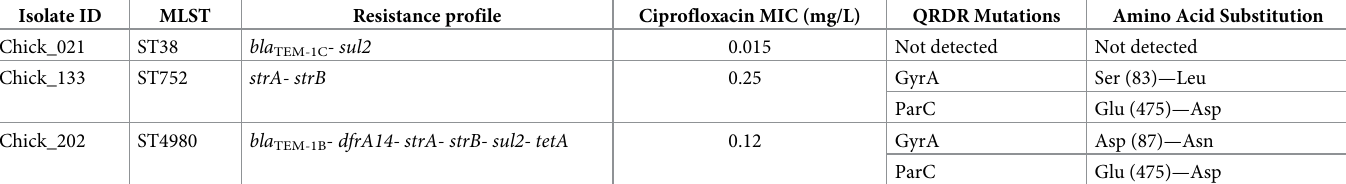
Table 5. MLST and profile of resistance genes identified in Escherichia coli isolates subjected to whole genome sequence analysis (n = 3). Isolate